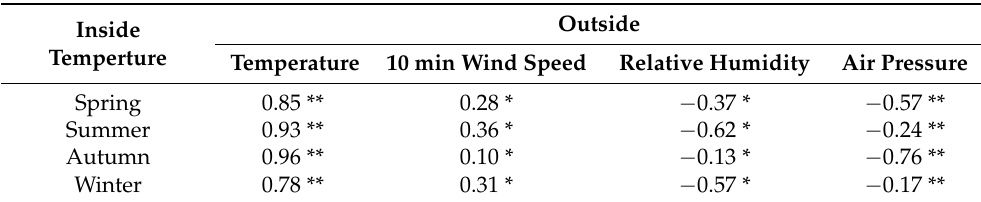
Table 2. The correlation coefficient between the inside temperature and the outside meteorological factors in different seasons.